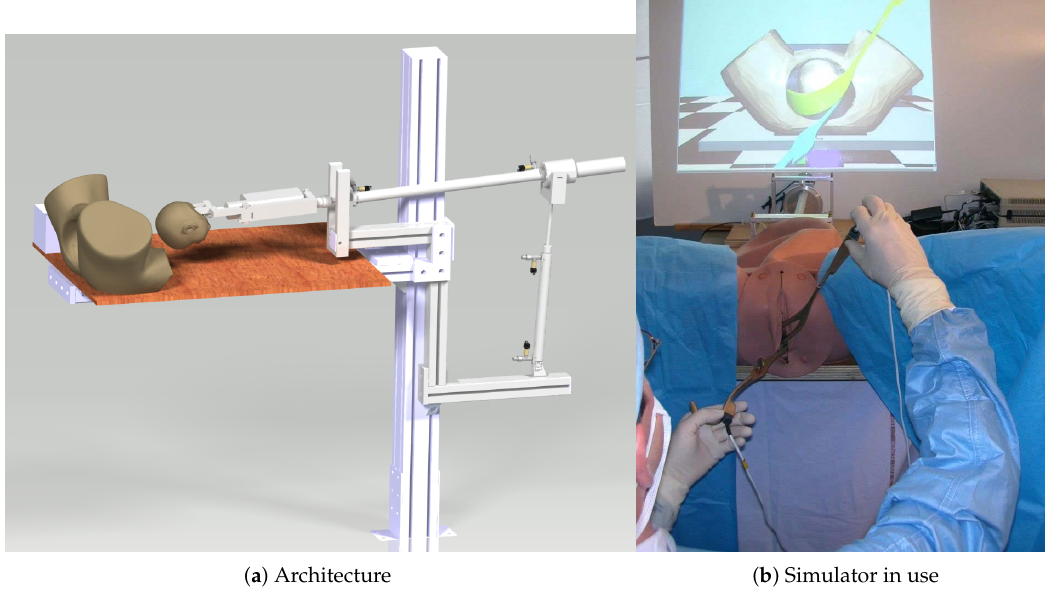
Figure 3. BirthSim: difficult chilbirth haptic